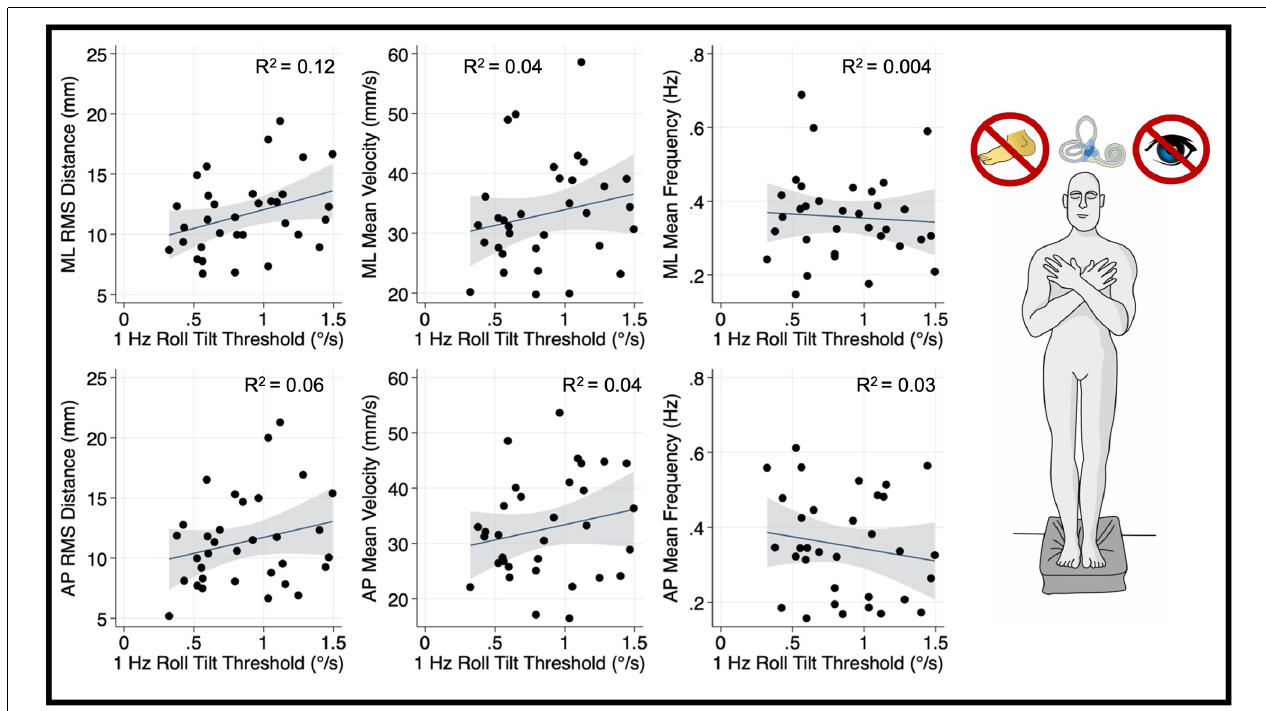
FIGURE 5 | Relationship between 1.0 Hz roll tilt thresholds and RMSD, mean velocity, and mean frequency for both the mediolateral plane (top) and anteroposterior plane (bottom) during an “eyes closed, foam” balance task. To the right of the plots, the task and relevant balance control systems are displayed, showing a dominance of vestibular cues in the “eyes closed, foam” condition. Each data point represents one individual’s performance. The blue line shows a linear fit with the 95% CI depicted by the gray shaded region. No statistically significant relationships were seen between 1.0 Hz thresholds and postural sway. RMSD, root mean square distance.